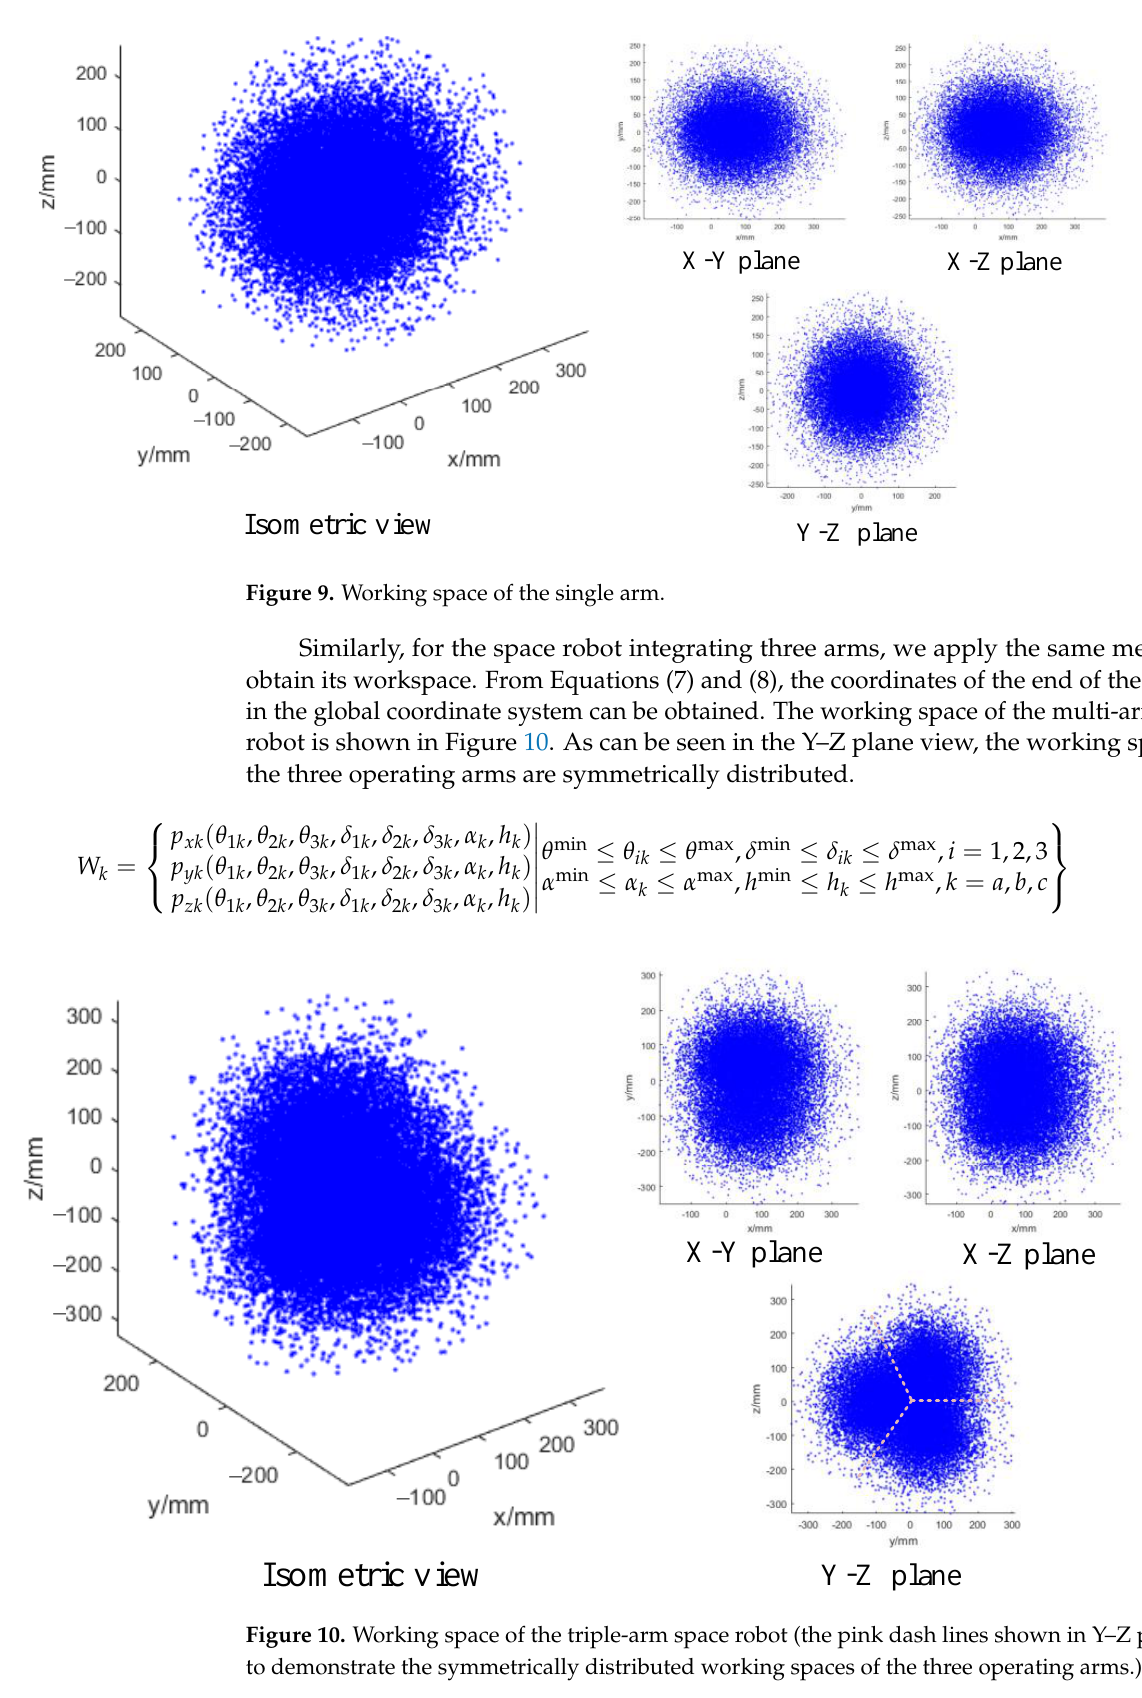
Figure 10. Working space of the triple-arm space robot (the pink dash lines shown in Y – Z plane are to demonstrate the symmetrically distributed working spaces of the three operating arms.).